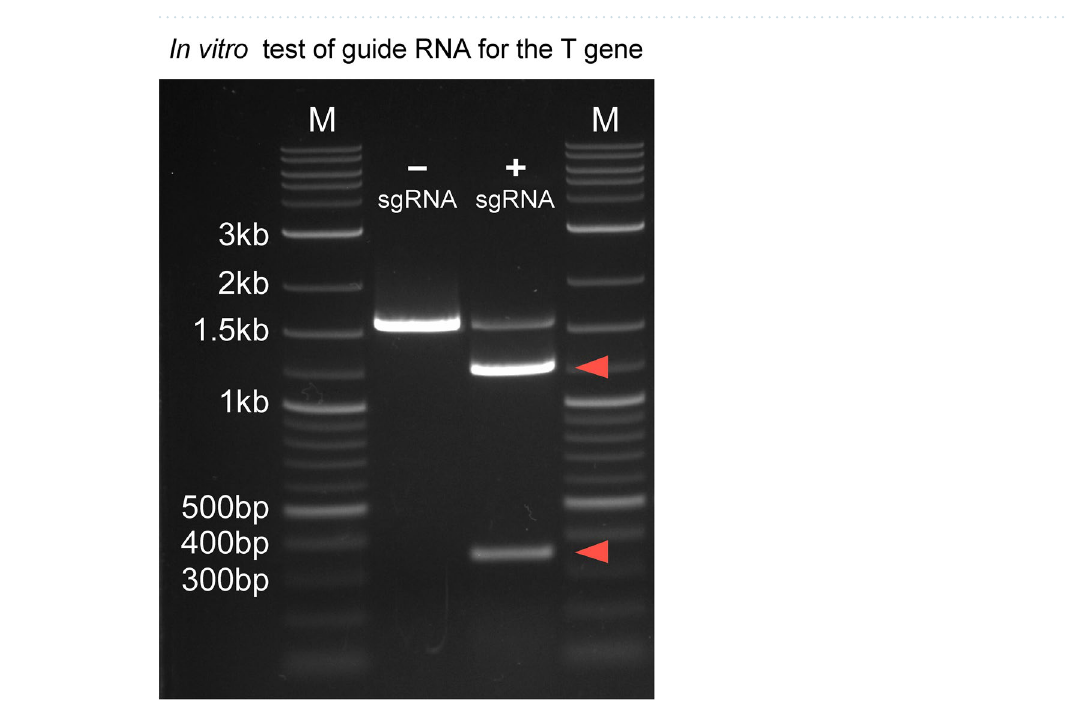
Figure 2. In vitro test of guide RNA for editing of the T gene. To detect CRISPR/Cas9-mediated cleavage at the intended targeted site in vitro, a 1592 bp region of the mouse T gene was PCR-amplified from genomic DNA and incubated with Cas9 protein and the single guide RNA (+ sgRNA). The control reaction contained the same substrate amplicon, and Cas9 protein, but no sgRNA (-sgRNA); the uncut PCR amplicon is close to 1.6 kb in size. Cleavage of the target amplicon by the sgRNA/Cas9 complex is detected by virtue of fragments of ~ 1250 bp and ~ 340 bp, respectively, in the sgRNA-containing sample (red arrowheads). M: Quick-Load® Purple 1 kb DNA Ladder (New England Biolabs, Ipswich,